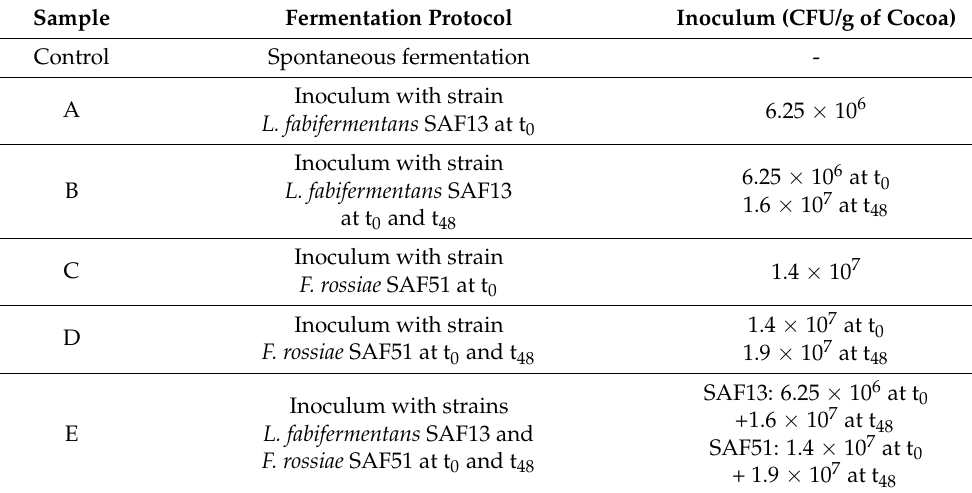
Table 1. Inoculation protocols and microbial counts for each